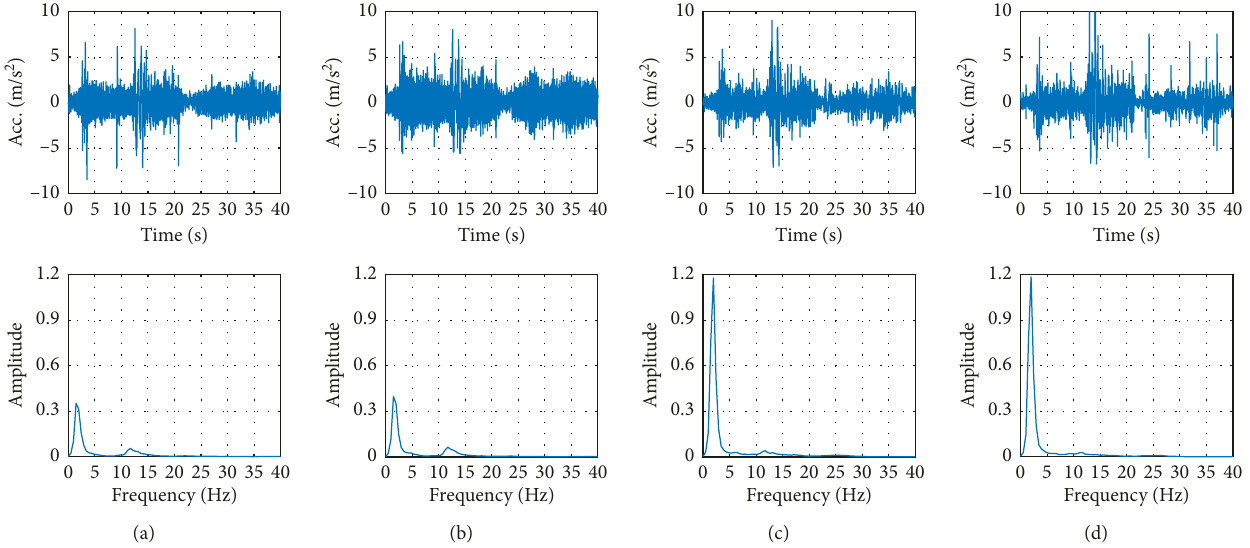
Figure 14: Time-domain signal and corresponding PSD. (a) Ch